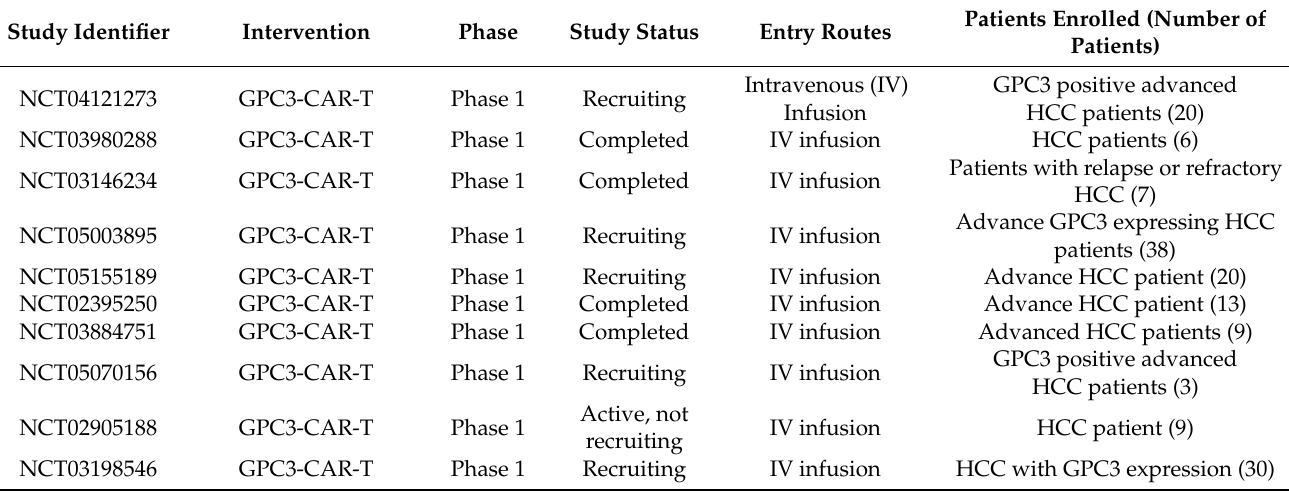
Table 5. Data from https://www.clinicaltrials.gov/ accessed on 10 May 2022 showing clinical trials that use chimeric antigen T cell (CAR)-T cell therapy for the treatment of advanced hepatocellular